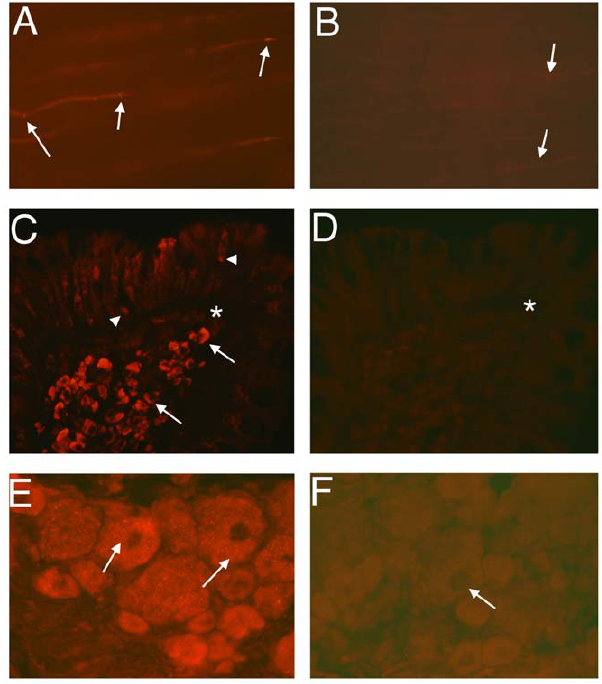
Figure 1. Immunofluorescence for CB 1 in normal Achilles tendon and in reference tissue. Panels show sections processed for CB 1 ( a,c,e ) and with CB 1 antibody preabsorbed with CB 1 antigen ( b,d,f ). Immunoreactions are shown in the elongated tenocytes in ( a ) but not in ( b ). Arrows indicate tenocytes. Immunoreactions are also seen in cells of the mucosa and submucosa (arrows) and the epithelial layer (arrowheads) of human colon in ( c ) but not in ( d ), and in cell bodies of a rat dorsal root ganglion in ( e ) but not in ( f ) (arrows). Asterisks in similar region in ( c ) and ( d ). Original magnification 6 40.